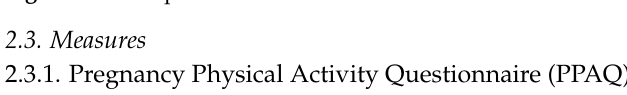
Figure 1. Participant flow.